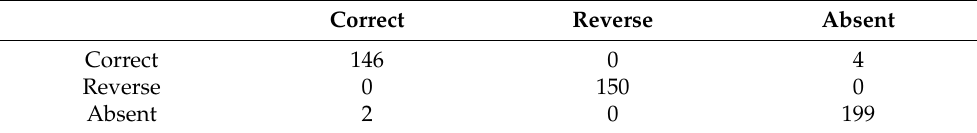
Table 4. Confusion matrix of the classification task, micro-averaged over the five folds. Correct Reverse Absent Correct 146 0 Reverse 0 Absent